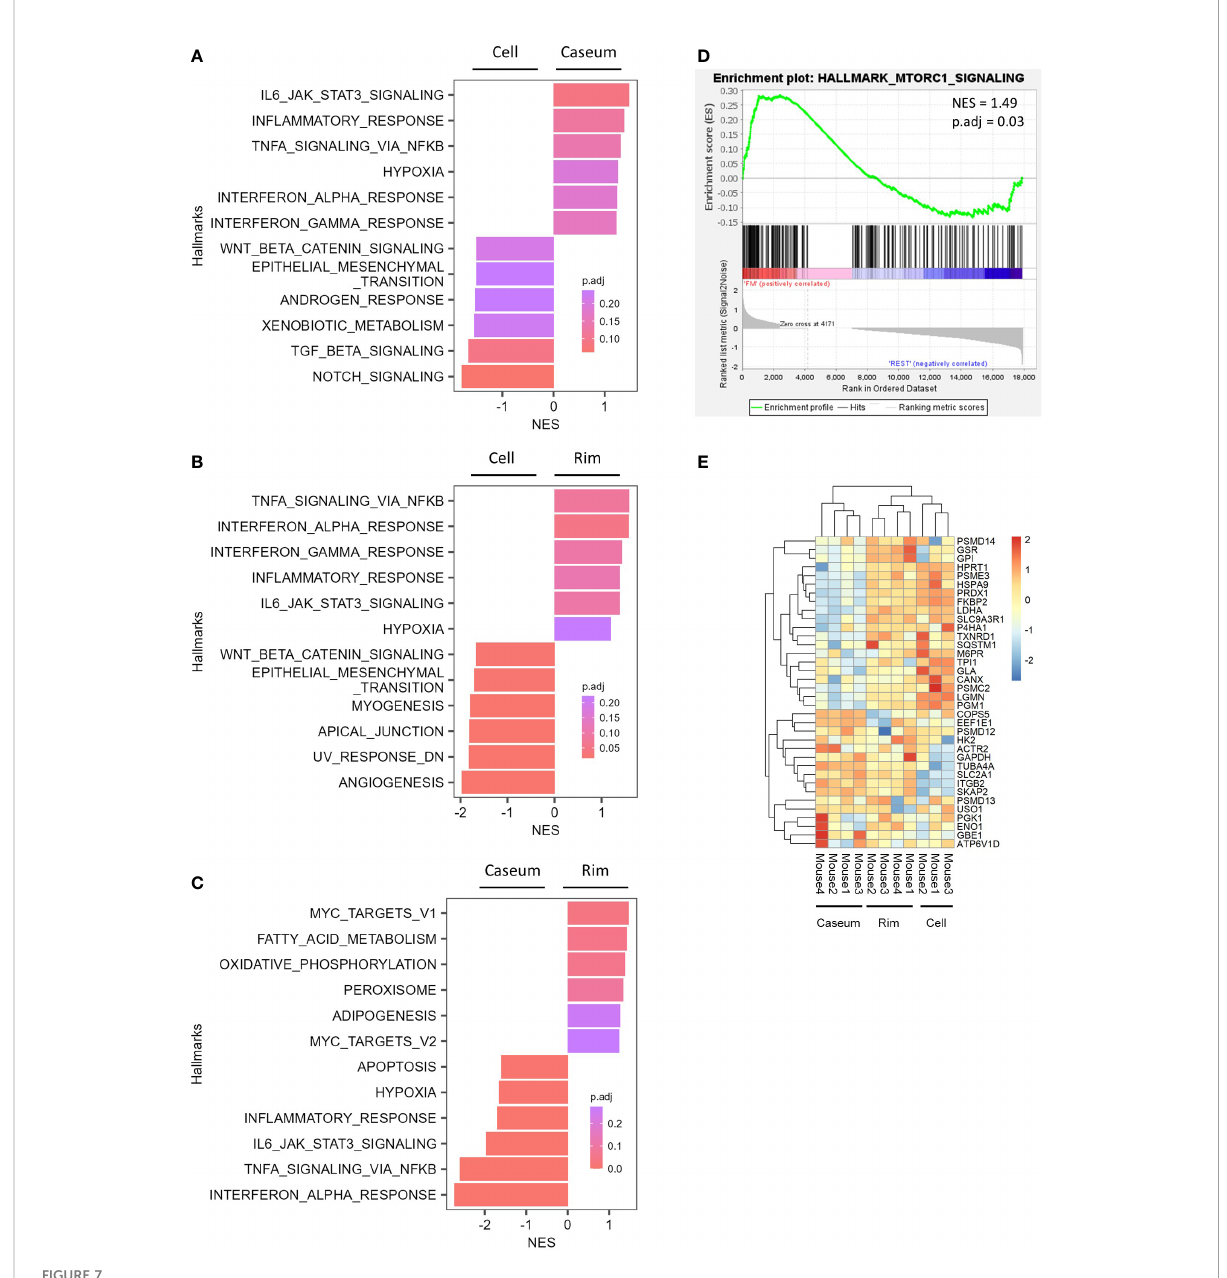
FIGURE 7 Expression of genes related to the activation of M2 macrophage and mTORC1 signaling in Rim of necrotic granulomas. (A – C) Gene set enrichment analysis (GSEA) showing enriched gene sets comparing between Caseum and Cell (B) , Rim and Caseum (C) , and Rim and Cell (D) fractions. GSEA was carried out using hallmark gene sets from Molecular Signatures Database. Normalized enrichment scores (NES) of the top six ranked hallmark gene sets are plotted with the color representing the adjusted P value (p.adj). (D) Enrichment plot for genes related to mTORC1 signaling. GSEA was carried out between Rim and other fractions. NES and p.adj are also shown. (E) Heatmap of hierarchical clustering of proteins related to fatty acid metabolism, oxidative phosphorylation, and mTORC1 signaling which correspond to the genes listed as the core enrichment in GSEA. Hierarchical clustering analysis was carried out based on the LFQ values of the indicated